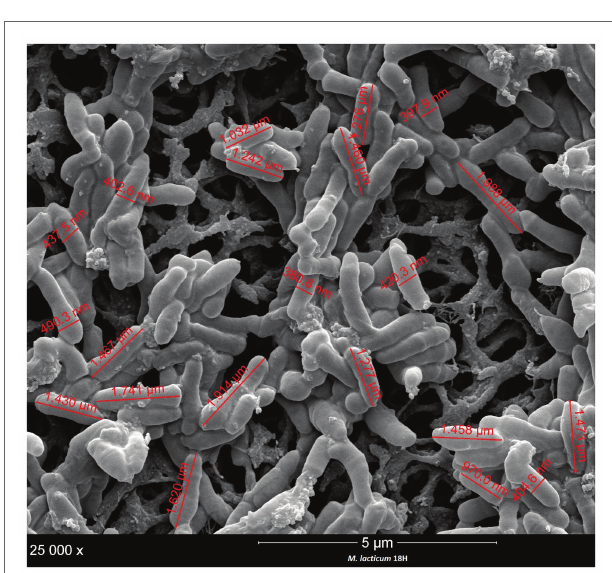
FIGURE 3 | Size and cell measurement of M. lacticum 18H by scanning electron microscopy (SEM) observation.